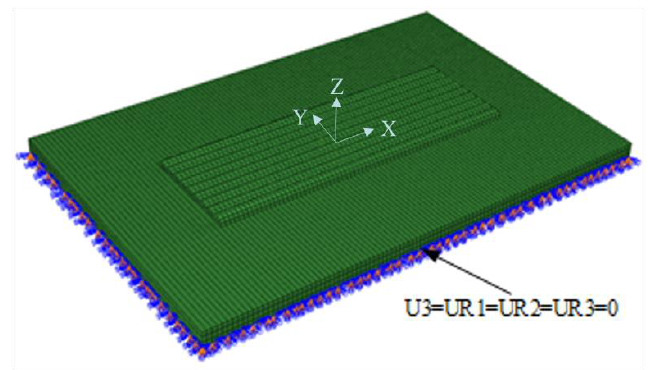
Figure 2. Applying displacement constraints on the substrate